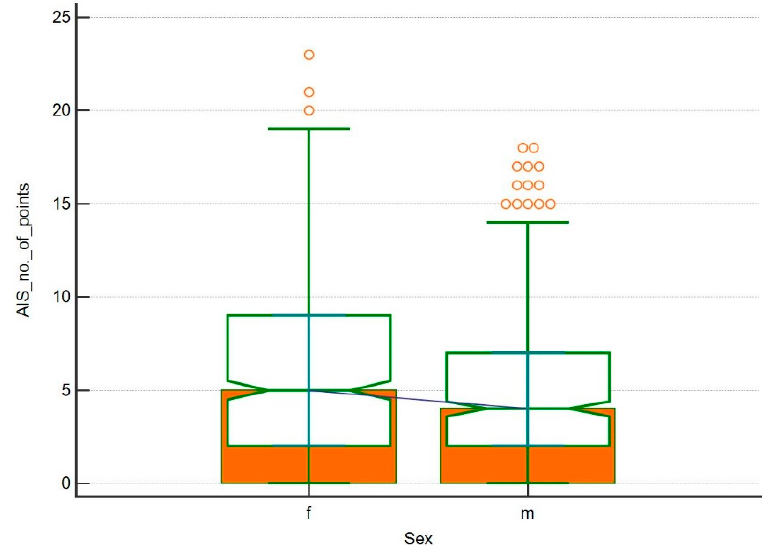
Figure 2. Number of points received by respondents in the Athens Insomnia Scale (AIS) questionnaire in relation to gender.